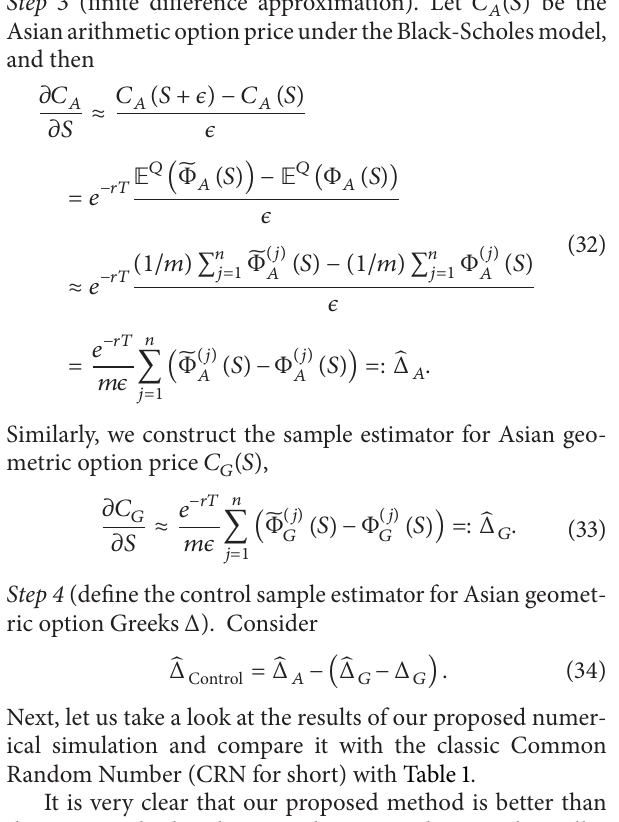
The table above is based on the Asian arithmetic option with the following parameters: 𝑆 = 60 , 𝑟 = 0.05 , sigma = 0.3, sample size 𝑛 = 5000 , time step 𝑚 = 500 , and initial stock price shock epsilon =